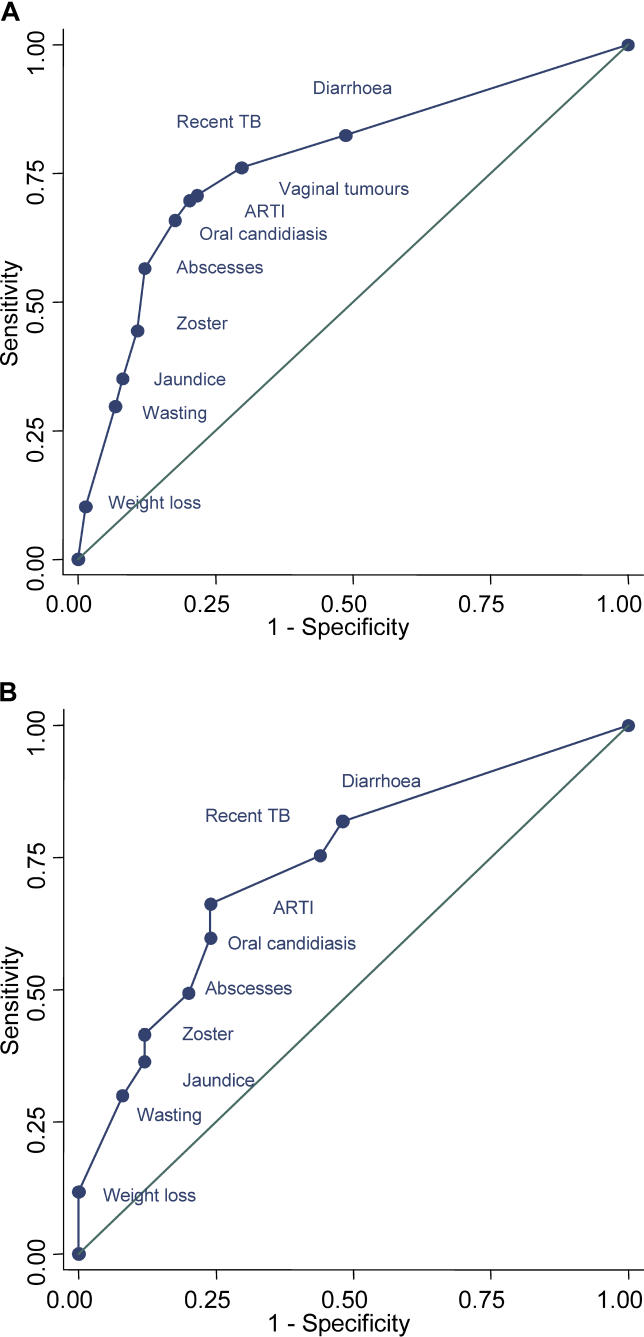
Modified Receiver Operator Characteristic Curves: Sensitivity Plotted against (1 − Specificity)Datasets are train (A) and test (B). In the test dataset, no individuals were reclassified as AIDS deaths because of presence of vaginal tumours; therefore no data point is plotted for that criterion in (B).